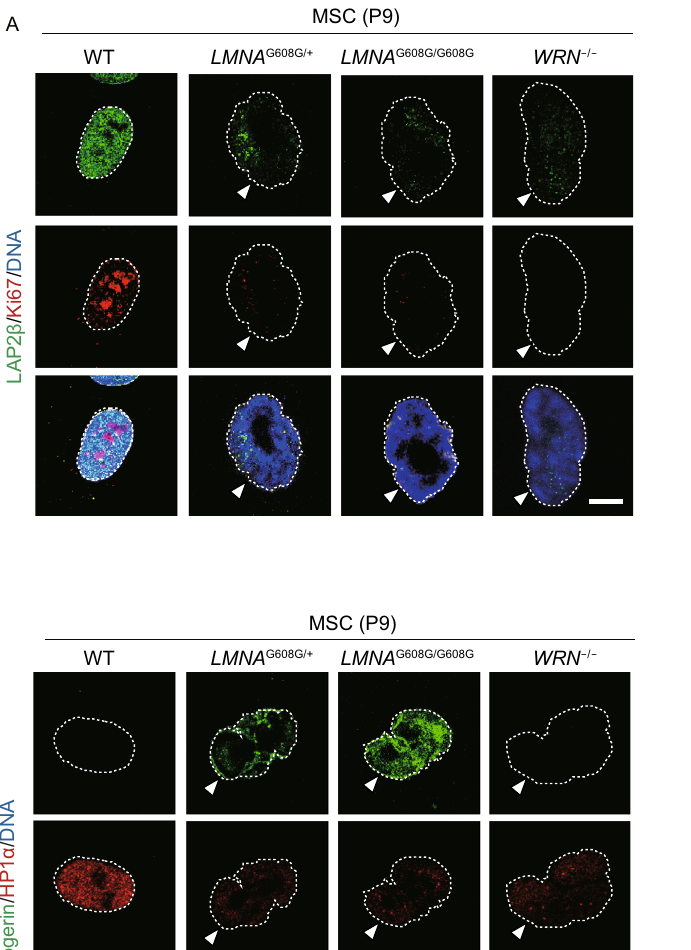
lines had typical endothelial morphology (Fig. 7B) and expressed endothelial-speci fi c markers (Fig. 7C). Despite the expression of progerin in HGPS-ECs and the loss of